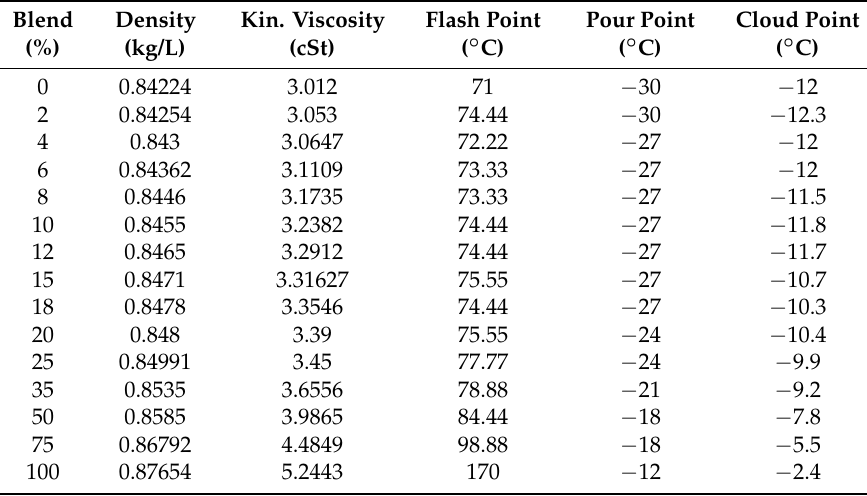
Table 2. The physical properties of diesel-biodiesel fuel